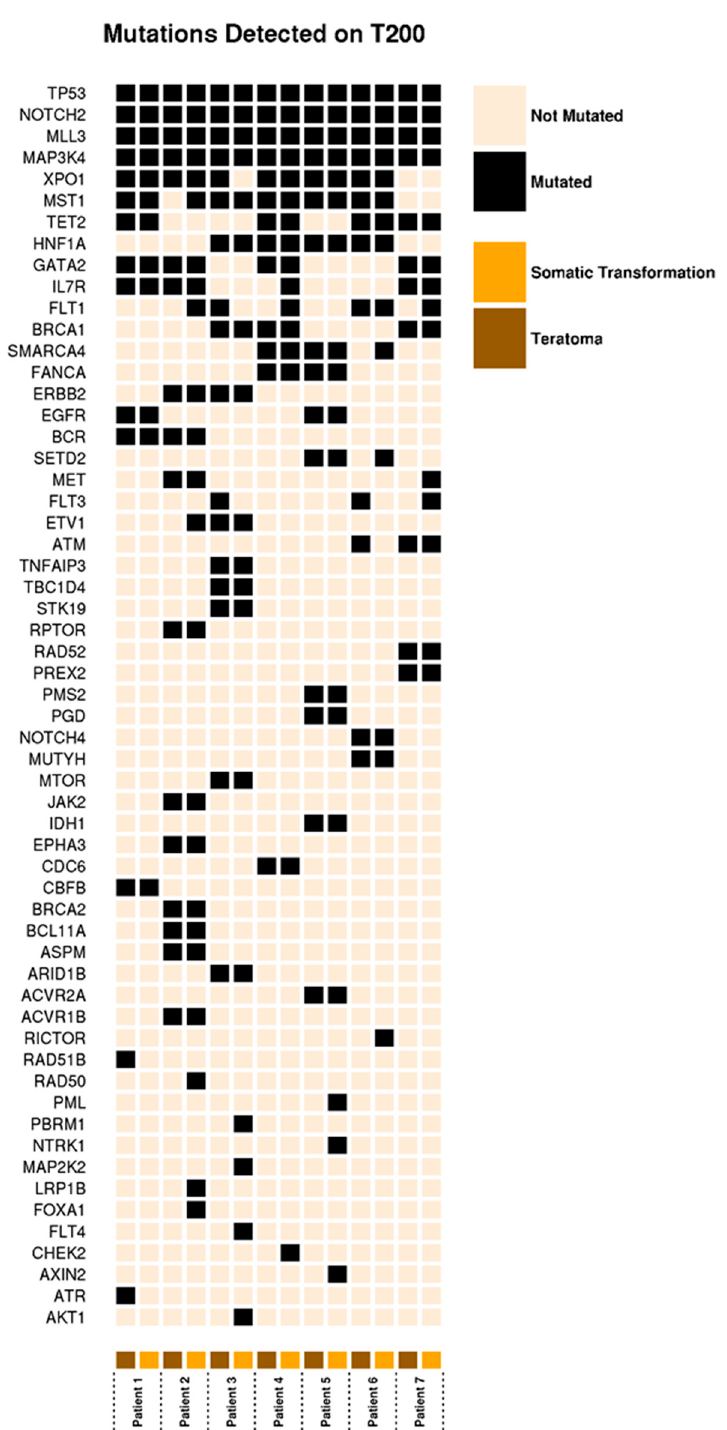
Figure 2. OncoPrint data of mutations detected in 14 samples across 7 patients.